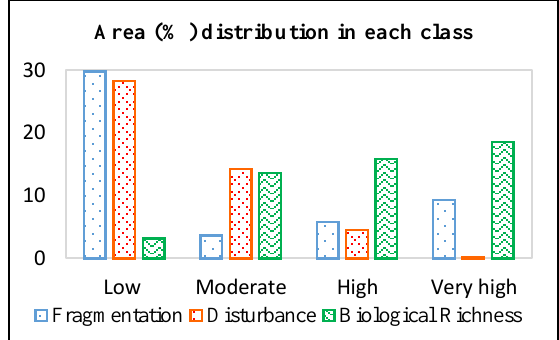
Figure 7. Area (%) statistics of forest fragmentation, disturbance and biological richness in four different classes